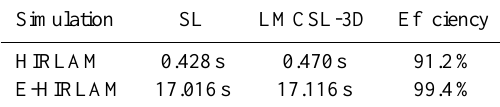
Table 2. Efficiency comparison between the SL scheme and the LMCSL-3D scheme when used as traditional NWP model and when using an online integrated condensed CBM-Z chemistry scheme with 32 additional advected tracers. The time in column two and three are the average time per time step during a 24h forecast.